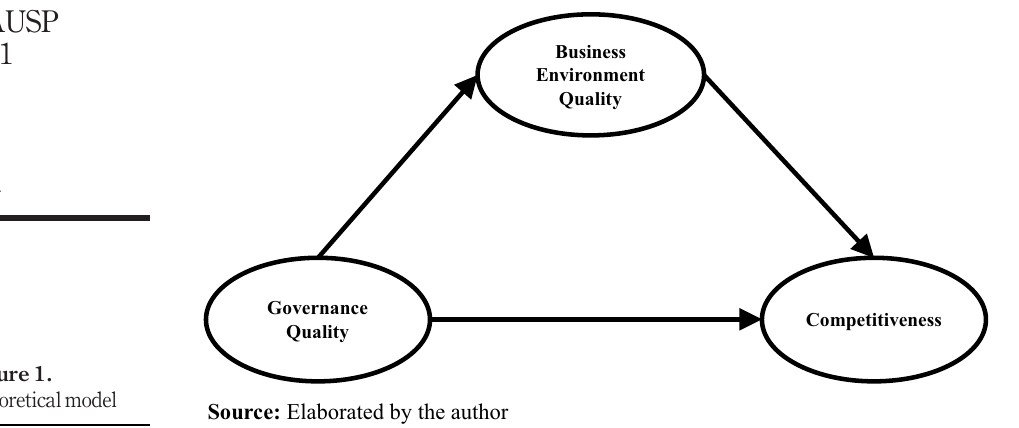
Figure 1. Theoretical